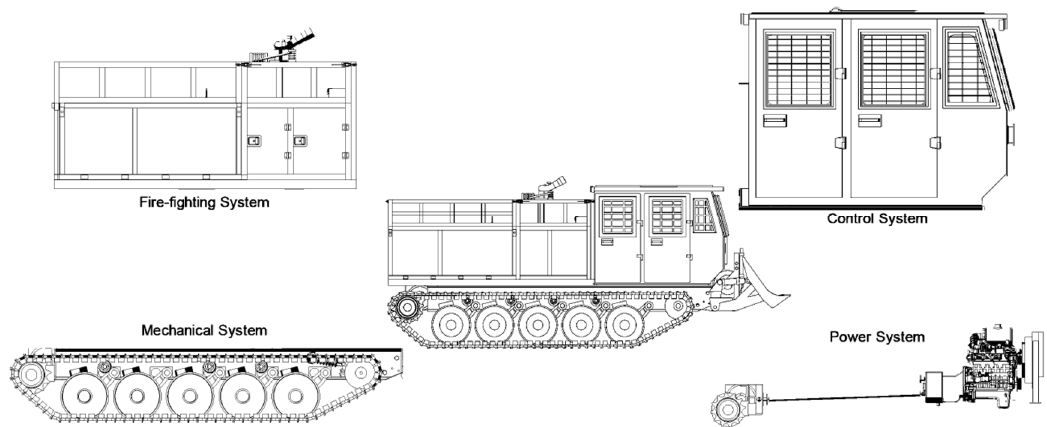
Figure 1. Two-dimensional model of the new tracked fire engine.